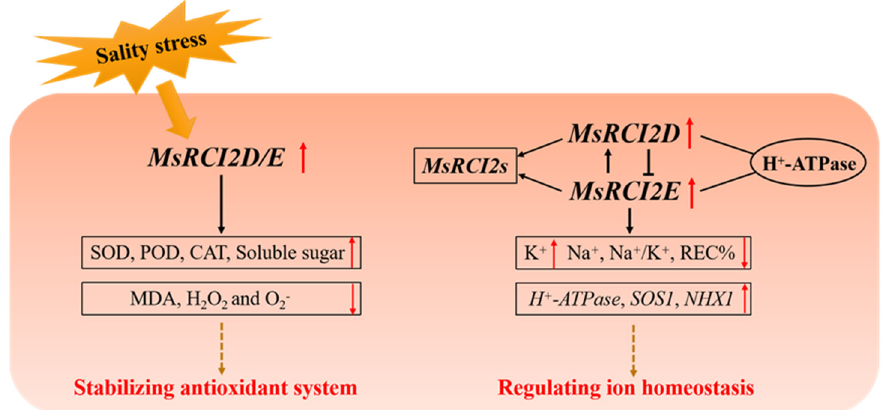
Figure 9. Functional model of the MsRCI2D/-E response to salinity stress. The main functions of MsRCI2D/-E are as follows: (1) ROS scavenging and stabilization of the antioxidant system in response to salinity stress and (2) differences in MsRCI2 gene expression and regulatory relationships with H + -ATPase , SOS1 , NHX1 , HKT1 , or MsRCI2 s.